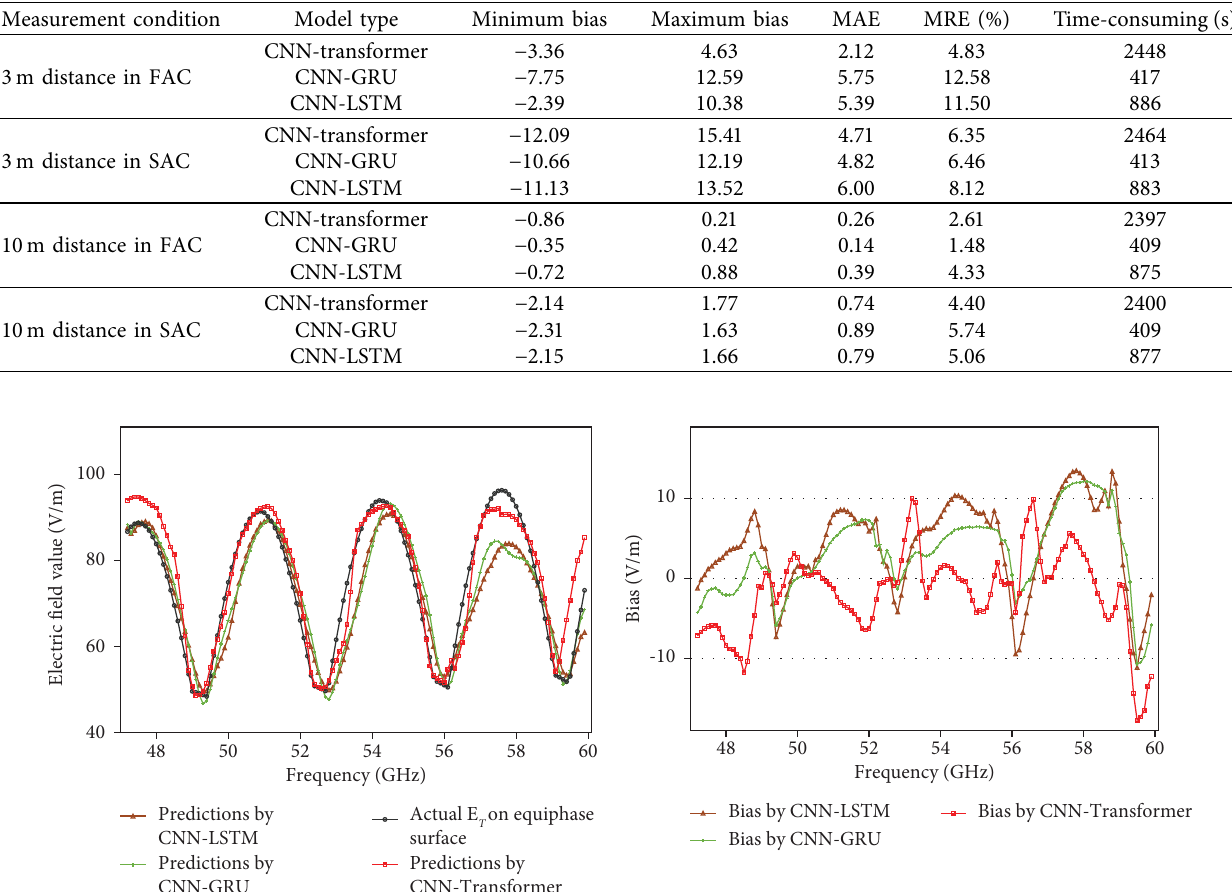
Table 2: Performance of the three deep learning models.